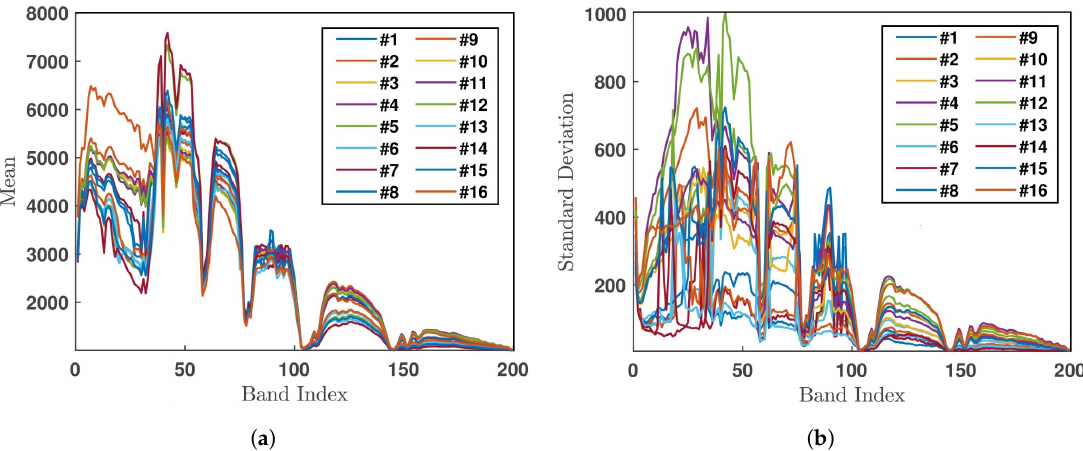
Figure 19. ( a ) Mean value and ( b ) standard deviation of all the pixels in each of 16 classes over all 200 bands in Indian Pines HSI.